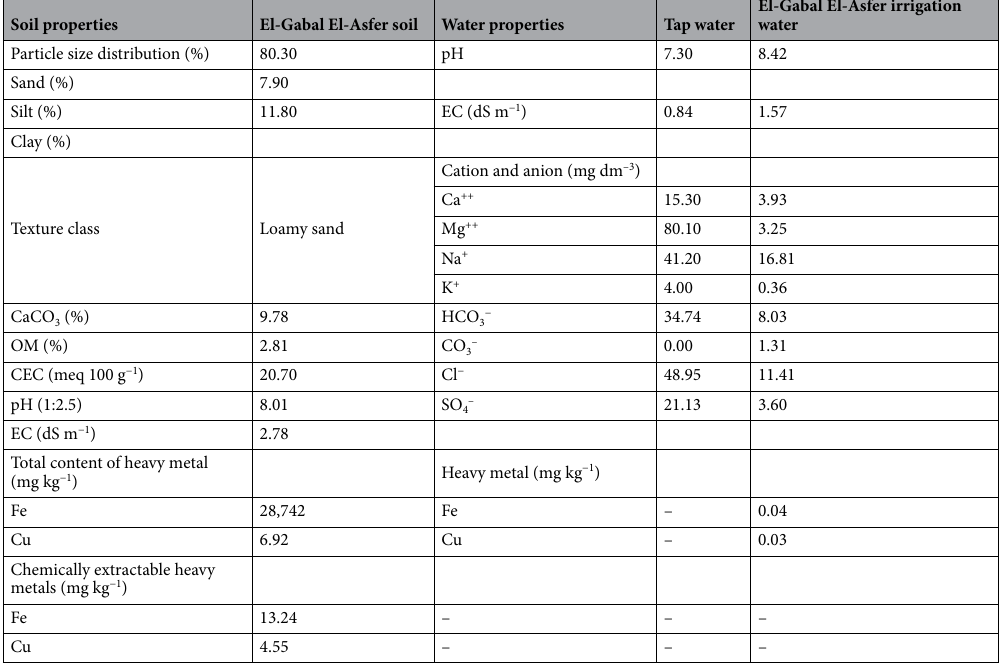
Table 1. Some physical and chemical properties of El-Gabal El-Asfer soil samples and irrigation